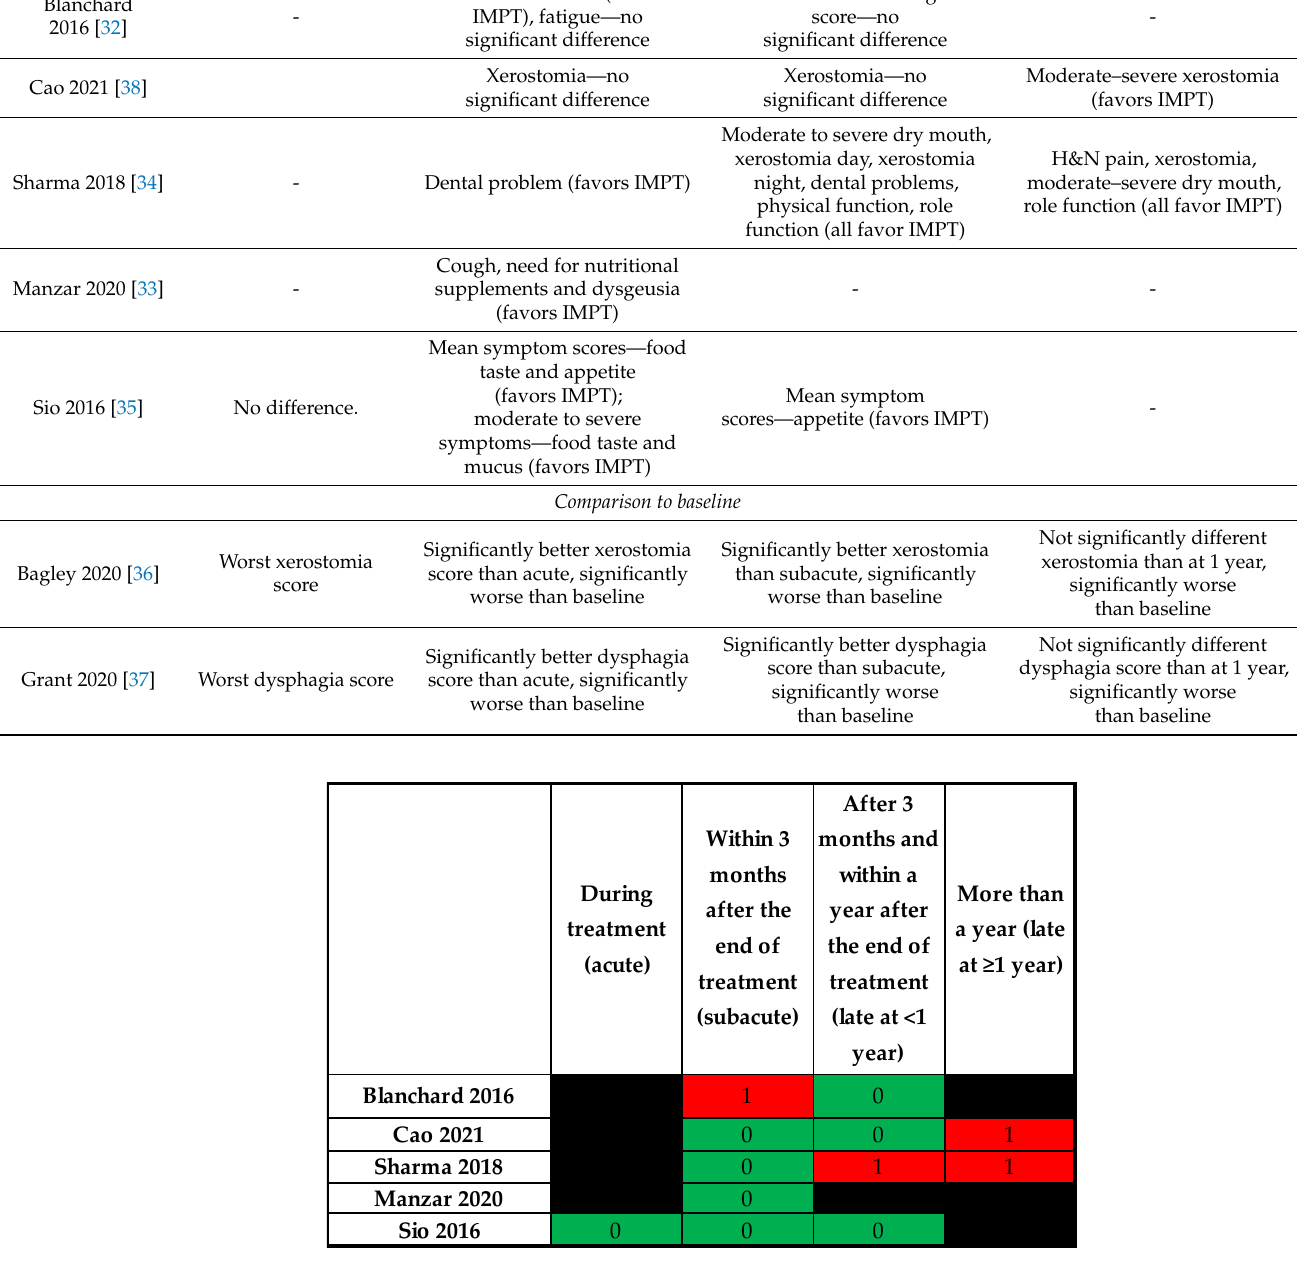
Figure 2. Patient-reported xerostomia between PBT and photon-based therapy at different time points. Red represents a significant difference (favoring PBT), and green represents no significant difference. None of the time points favor photon-based therapy (Blanchard 2016 [32], Cao 2021 [38], Sharma 2018 [34], Manzar 2020 [33] and Sio 2016 [35]).